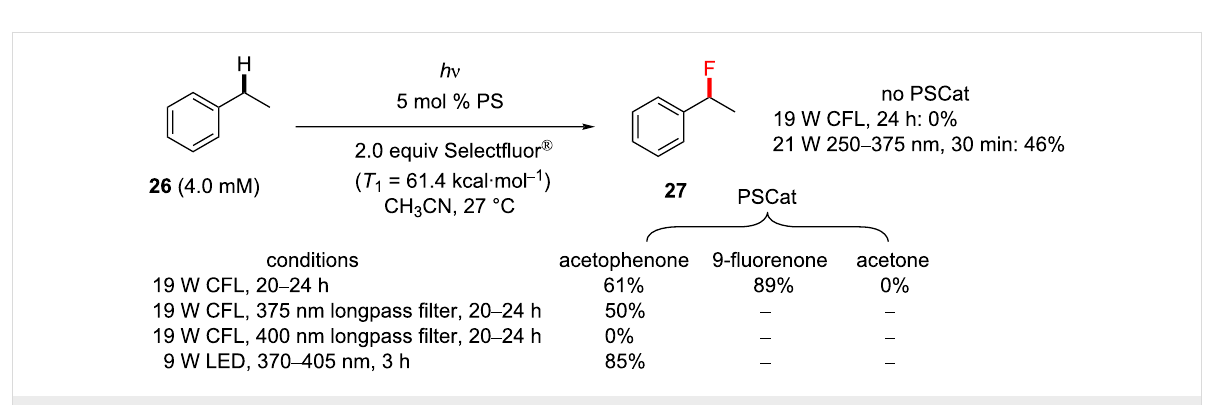
Scheme 12: Associated transitions for the activation of acetophenone by violet light.